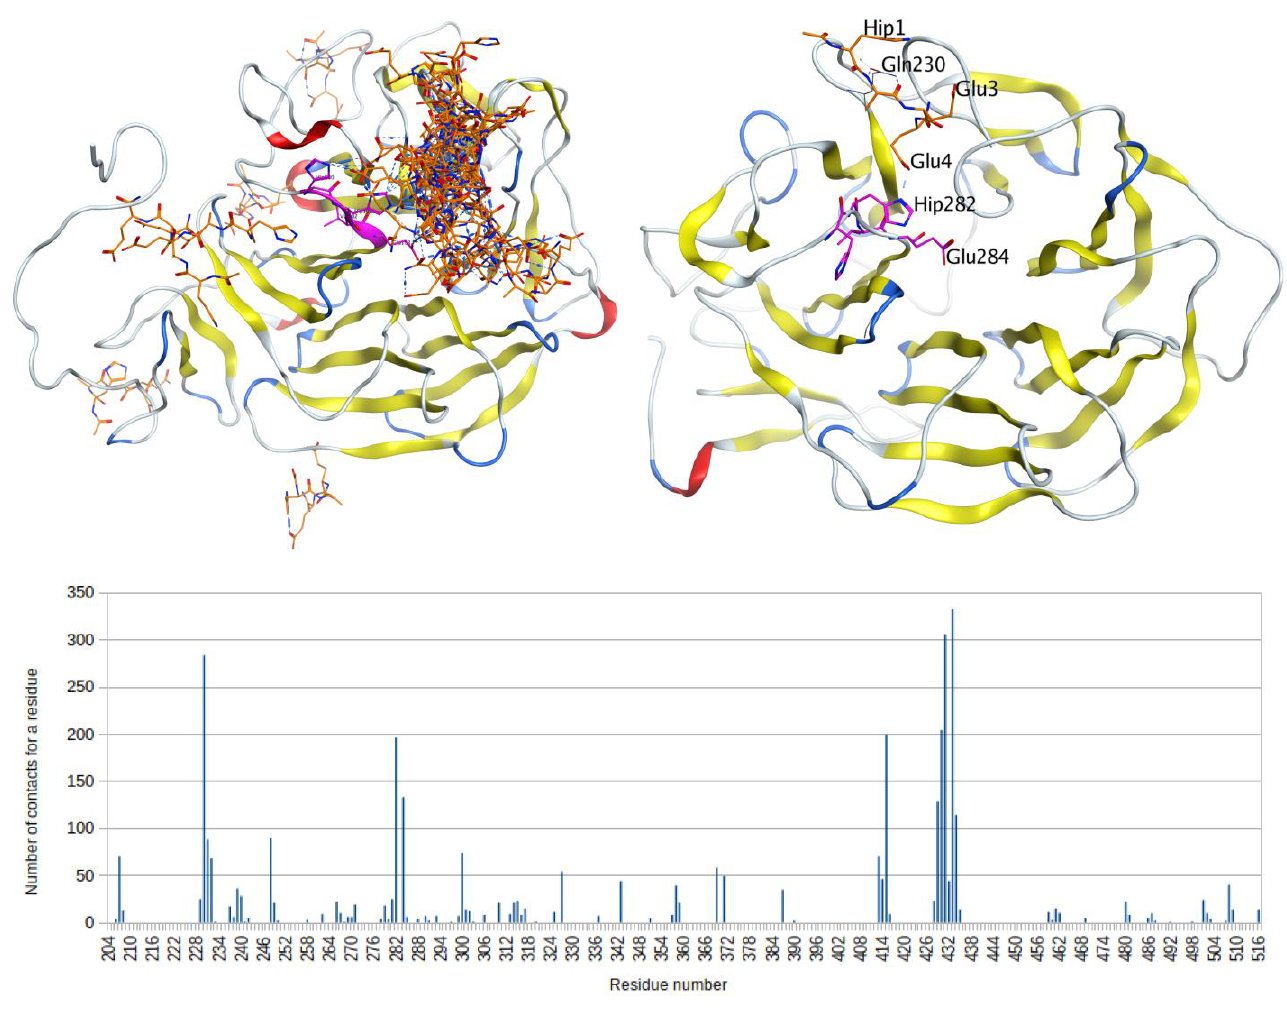
Figure 5. Results of global docking of the protonated tetrapeptide HAEE (marked orange) to LRP1 (left), and the structure of the model with the initial location of the tetrapeptide relative to the HHVE site after 50 ns MD (right). The HHVE site is marked pink. The bar graph shows the total number of contacts for all docking models for each amino acid residue of LRP1.